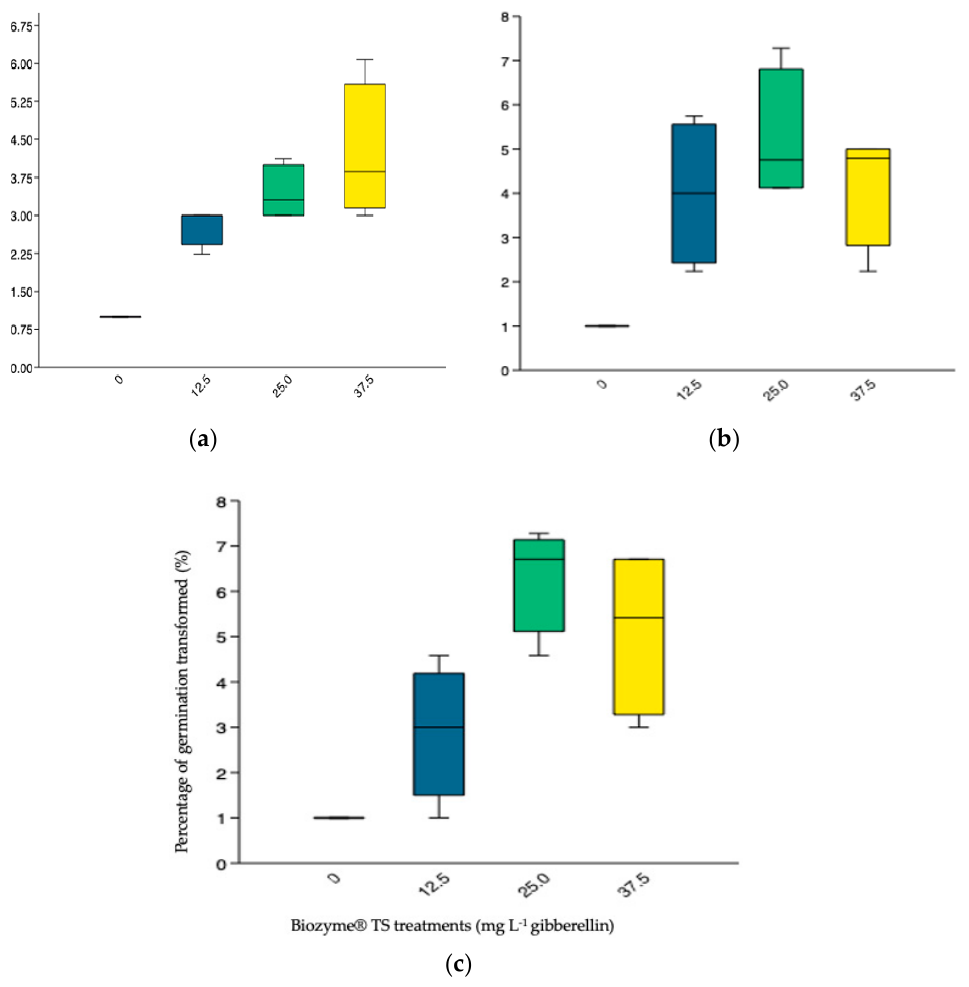
Figure 5. Response of germination percentage (GP) (transformed values) to Biozyme ® TS (gibberellins), with: ( a ) 24 h, ( b ) 48 h, and ( c ) 72 h of immersion. Table 3. Comparison of means of germination percentage (GP) (transformed values) with 24, 48, and 72 h of immersion in Biozyme ® TS (gibberellins), according to Tukey HSD. I. T., h.